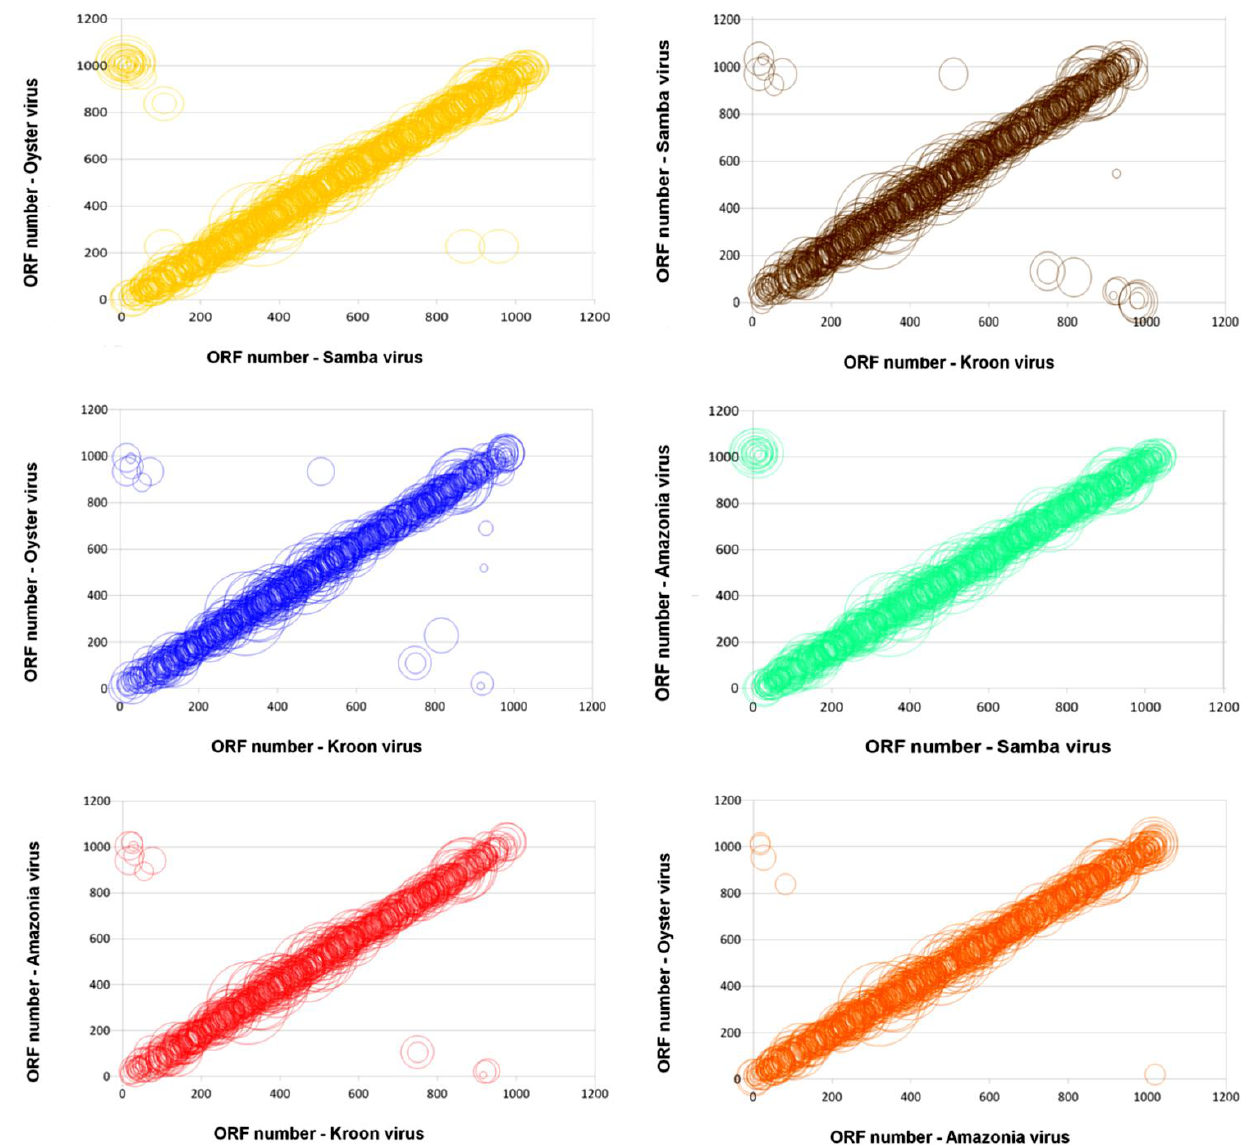
Figure 4. Genomic dot-plots based on a BLASTp analysis for pairs of Brazilian mimiviruses. Each circle shows a pair of orthologous proteins found in each pair of Brazilian mimiviruses. The diameters of the bubbles are proportional to the BLASTp similarity scores, and their positions are relative to the position of each pair in the genome.